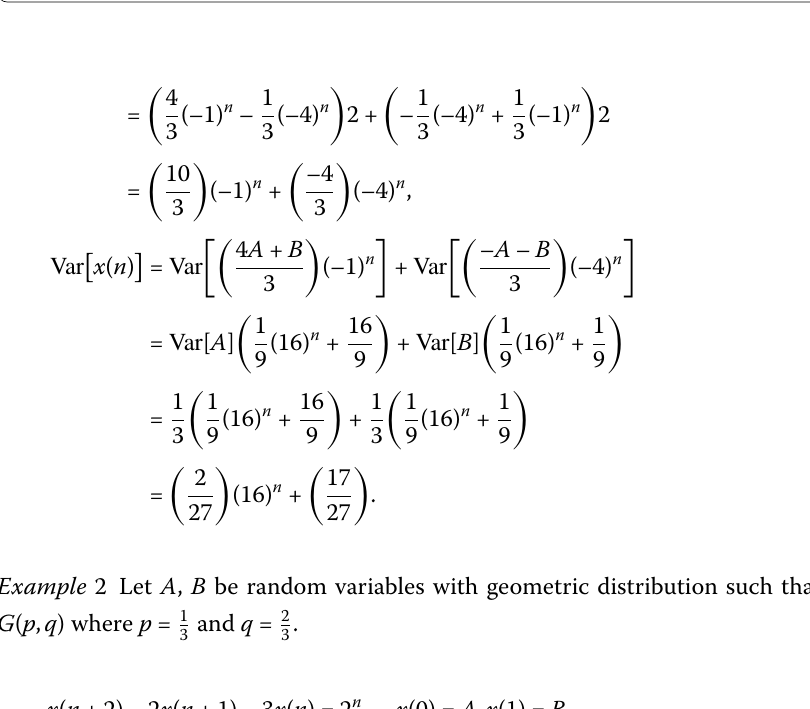
Figure 1 Expected value and variance obtained from the Z-transform of